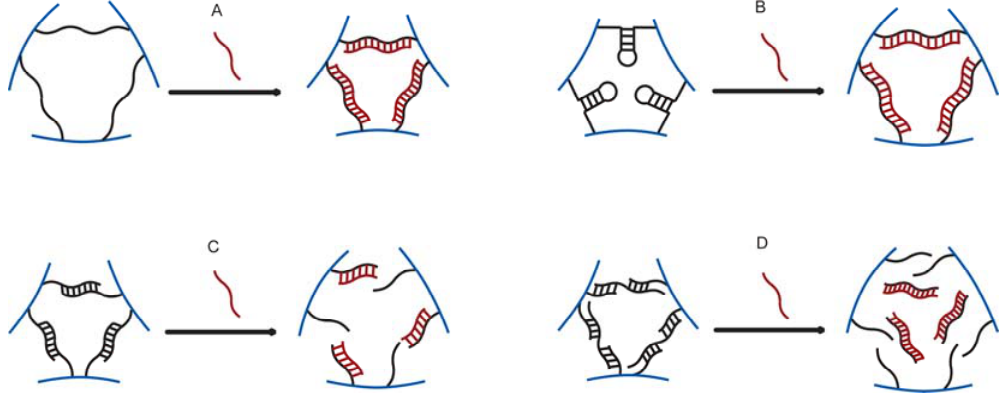
Figure 4. Schematics of DNA-crosslink designs and hydrogel swelling/shrinking mechanisms: (a) ssDNA with both ends anchored in the hydrogel network—shortening of the crosslinks upon binding of a complementary ssDNA probe [50], (b) ssDNA with intramolecular stem-loop base pairing with both ends anchored in the hydrogel network—elongation of the crosslinks upon binding of a complementary ssDNA probe [50], complementary ssDNA—dissociation of the crosslinks upon complementary displacement in the presence of complementary ssDNA